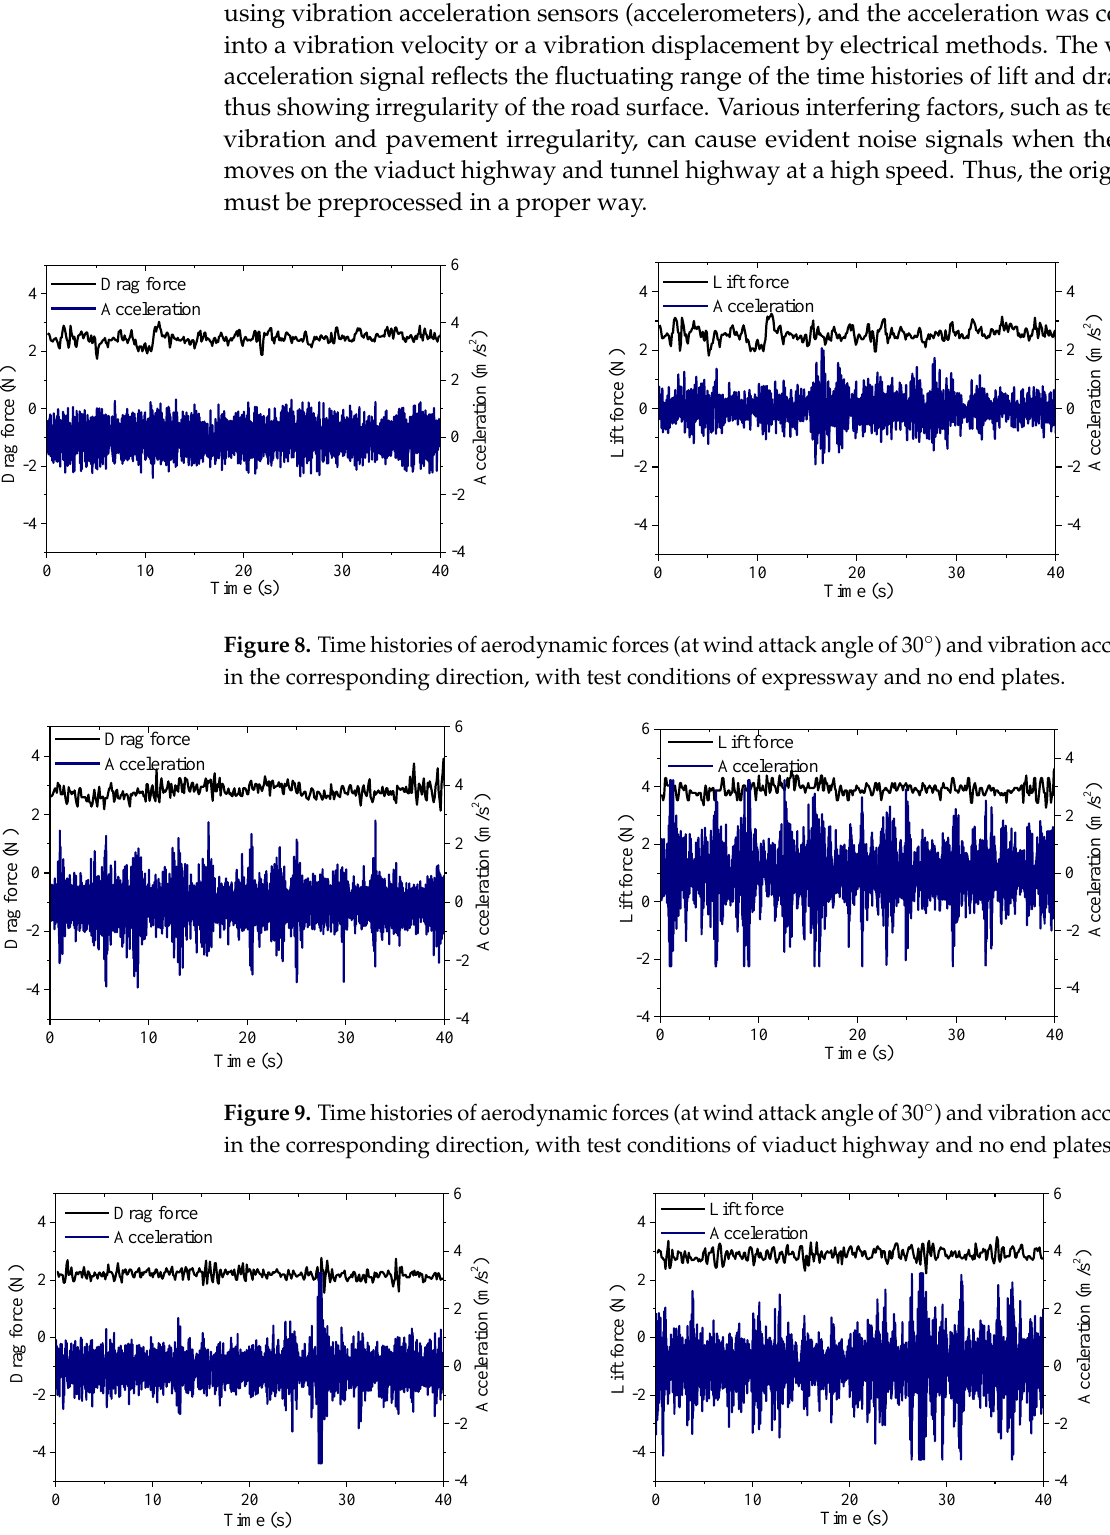
Figure 10. Time histories of aerodynamic forces (at wind attack angle of 30°) and vibration accelerations in the corresponding direction, with test conditions of tunnel highway and no end plates.